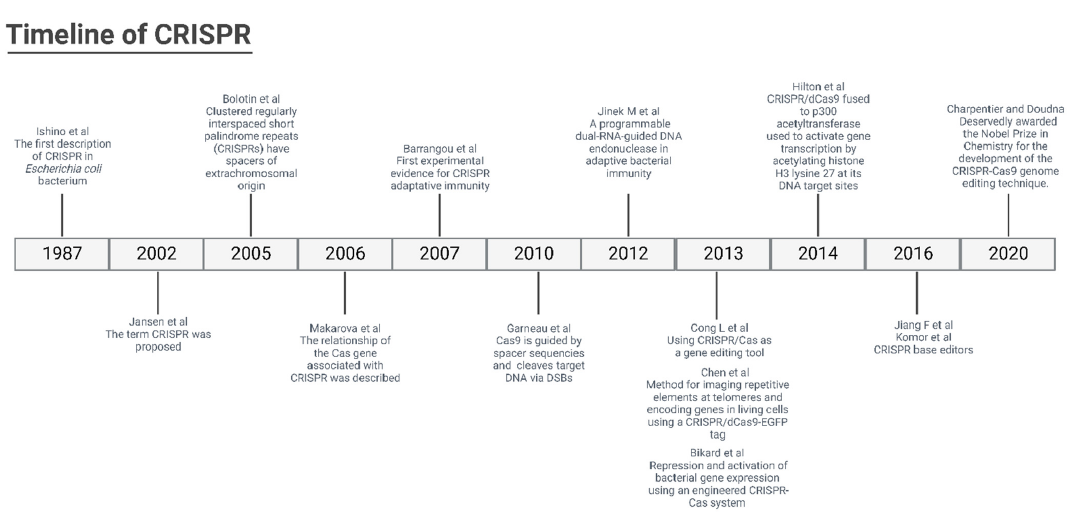
Figure 1. Timeline of CRISPR technology [16–19,21,25–32].